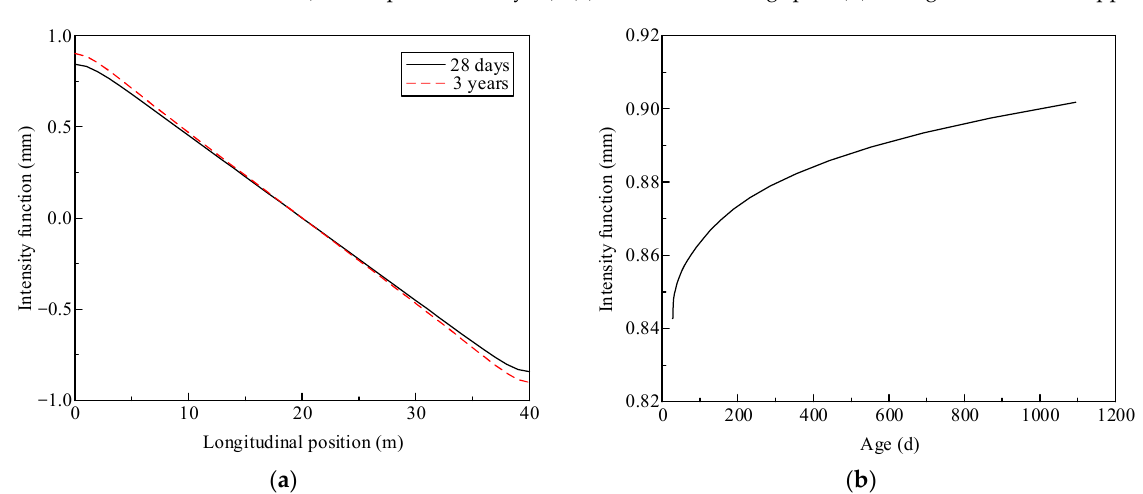
Figure 16. Warping intensity function of the steel bottom induced by shear deformation of the composite beam (time-dependent analysis). ( a ) Distribution along span; ( b ) Change with time at support section.